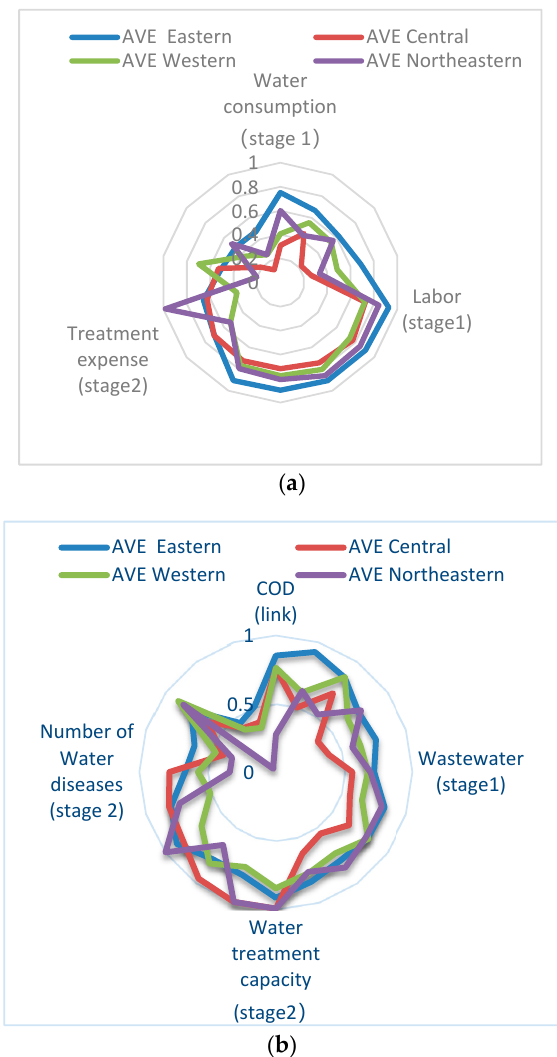
Figure 4. ( a ) Input variables radar map from 2013 to 2017. ( b ) Output variables’ radar map from 2013 to 2017.